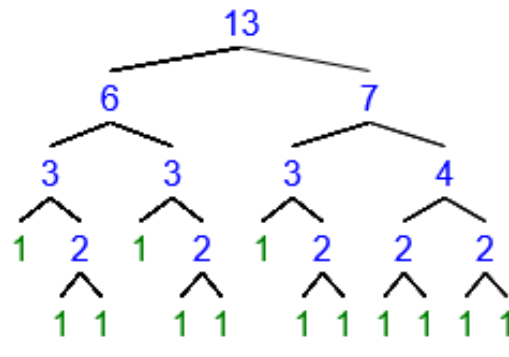
Figure A3. An illustration of